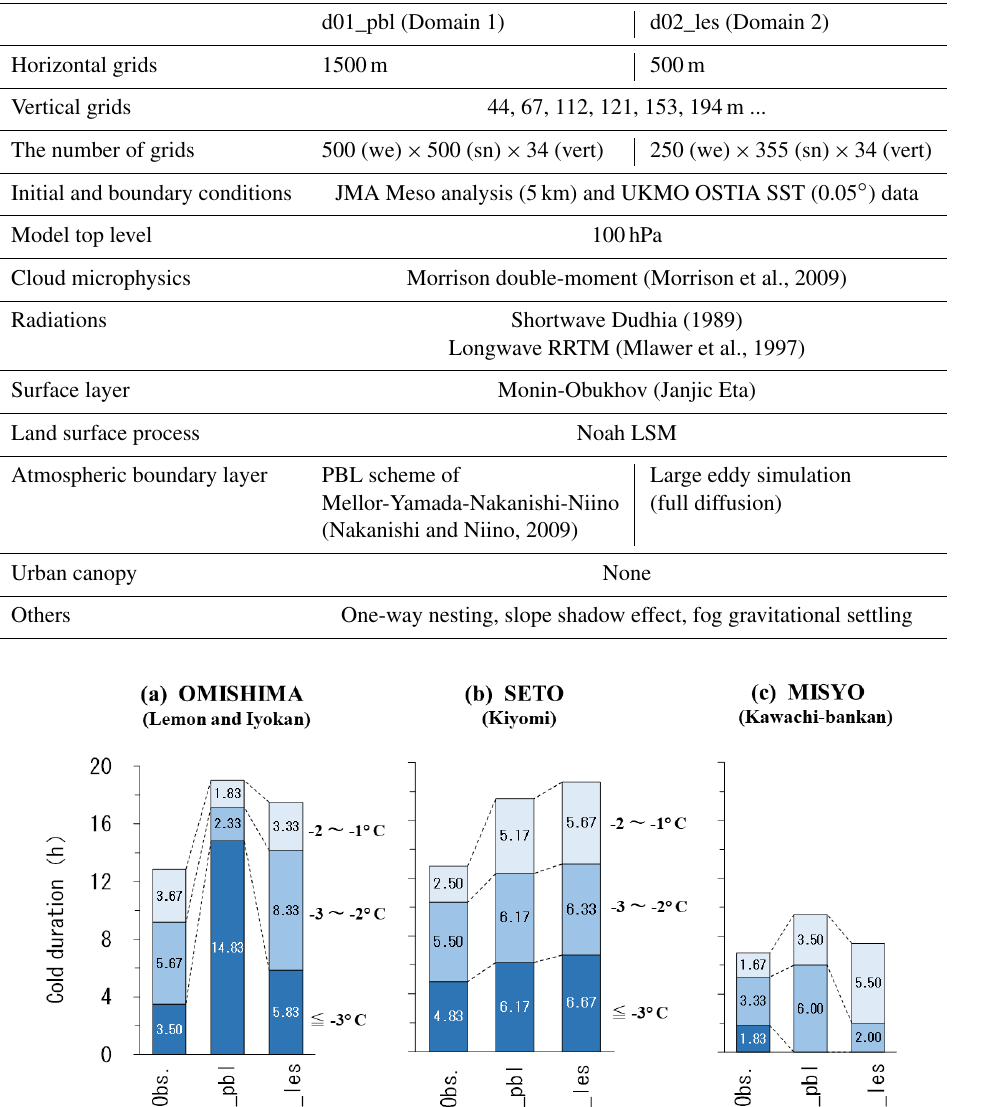
(ref., each site location in Fig. 2). This cold duration was inte- grid are 16, 86, and 15 m above sea level (a.s.l.), respectively.